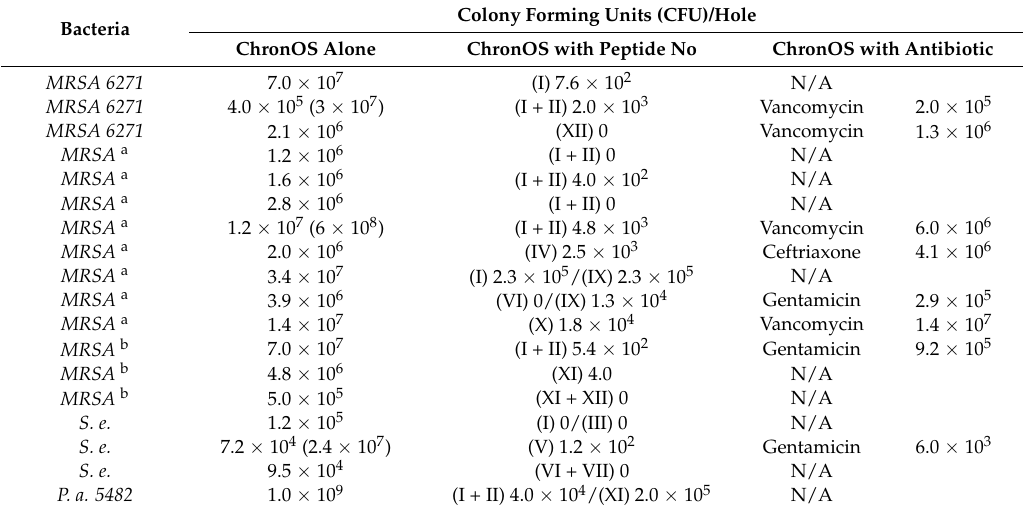
Table 3. Effect of selected AMPs on eradication of infection inside the bone tissue.